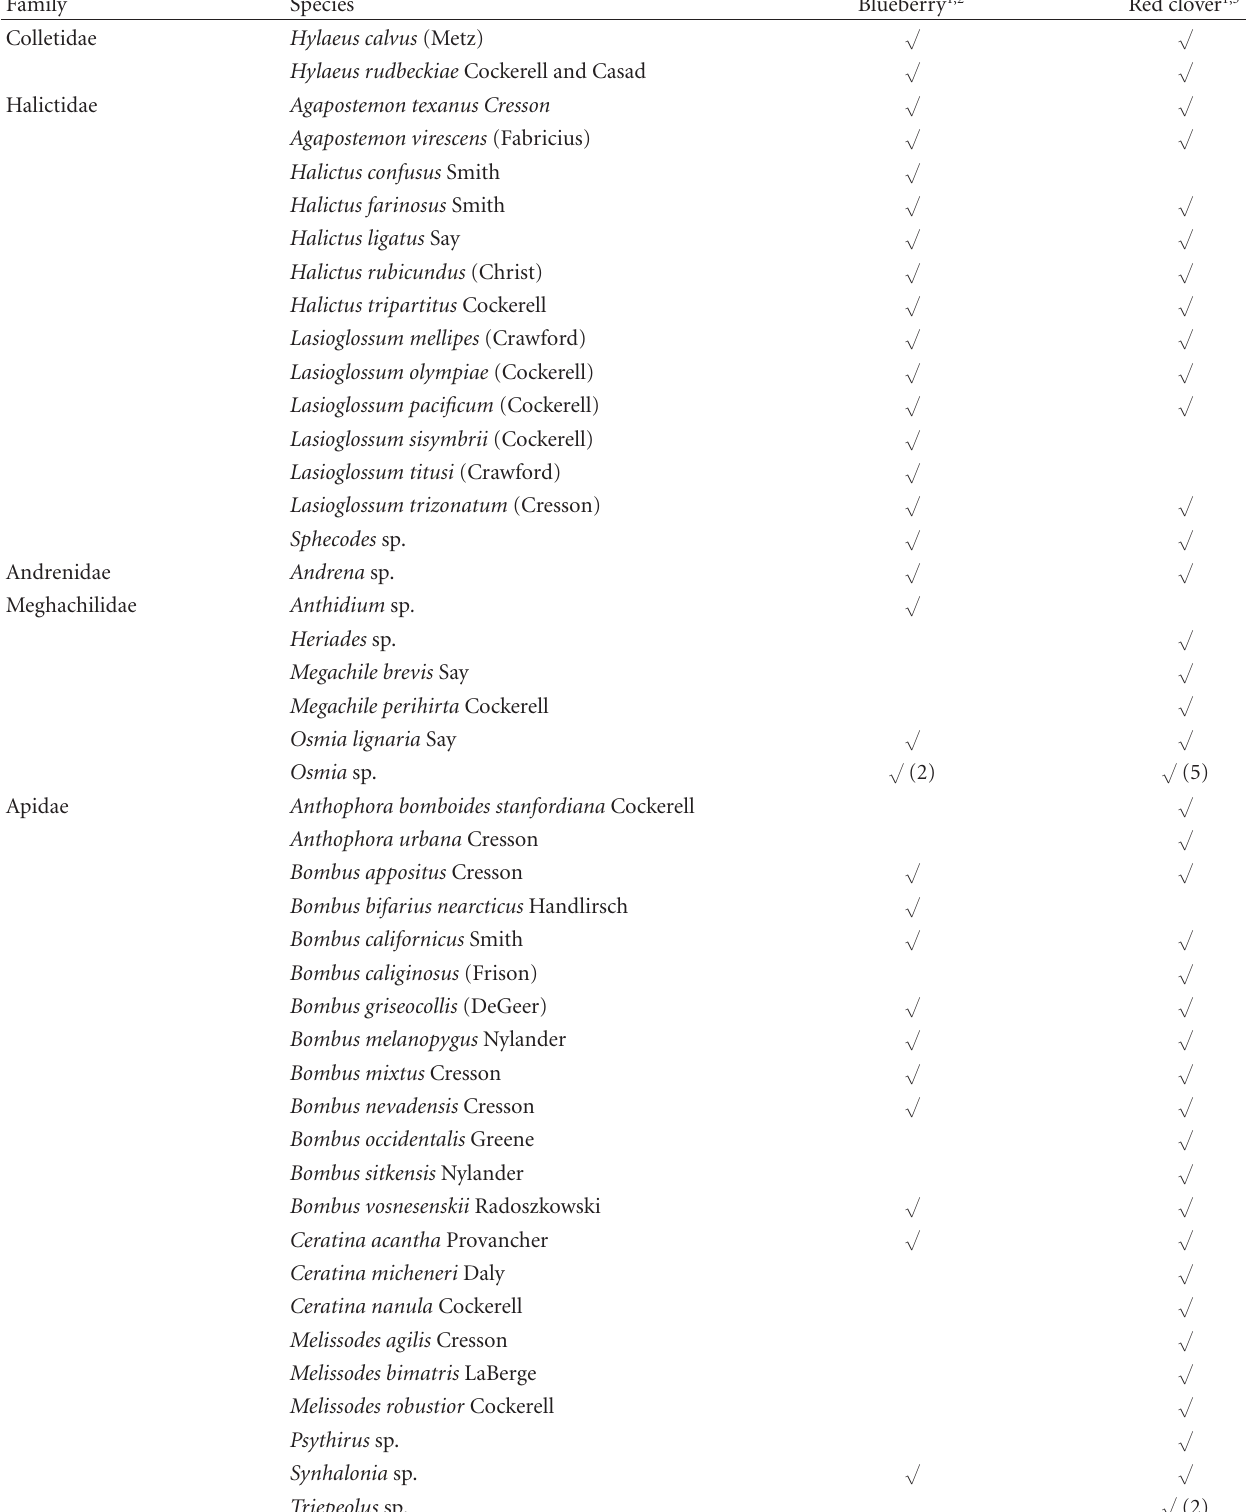
Table 2: Endemic bees captured and observed as foragers during bloom in blueberry and red clover seed crops in the Willamette Valley in studies conducted between 2005 and